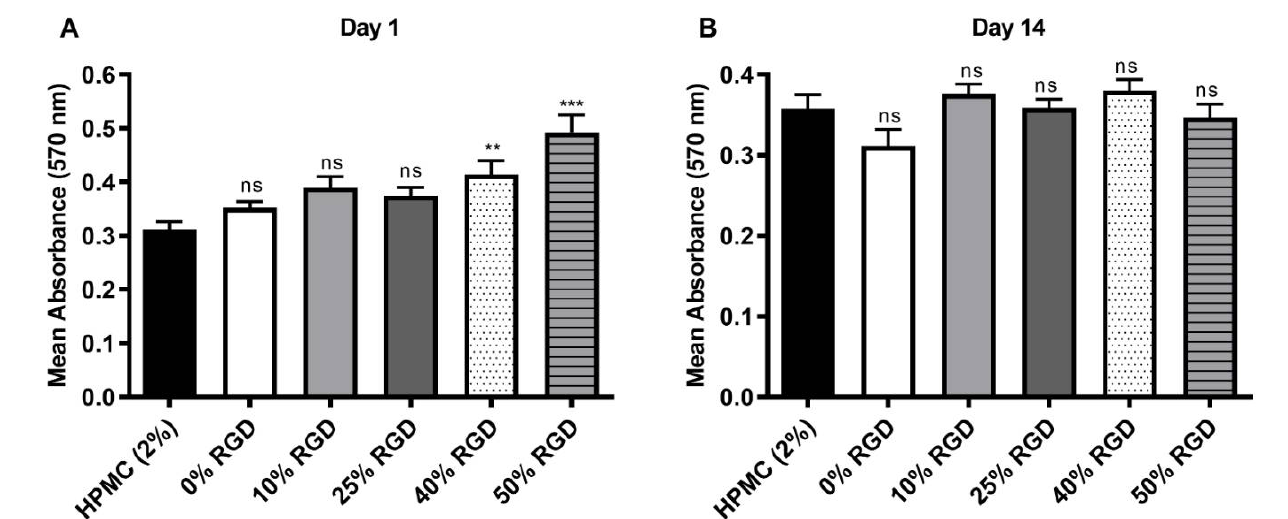
Figure 3. Modified MTT assay (for 3D culture) following encapsulation of DPSCs in HPMC hydrogel and 0–50% RGD assembled hydrogels at ( A ) day 1 and ( B ) day 14. All comparisons were made with the HPMC control. Data are from three experiments, with at least three replicates per experiment. Kruskal–Wallis test with Dunn’s correction for multiple comparison testing. ns: non-significant ( p > 0.05), **: p ≤ 0.01, ***: p ≤ 0.001.